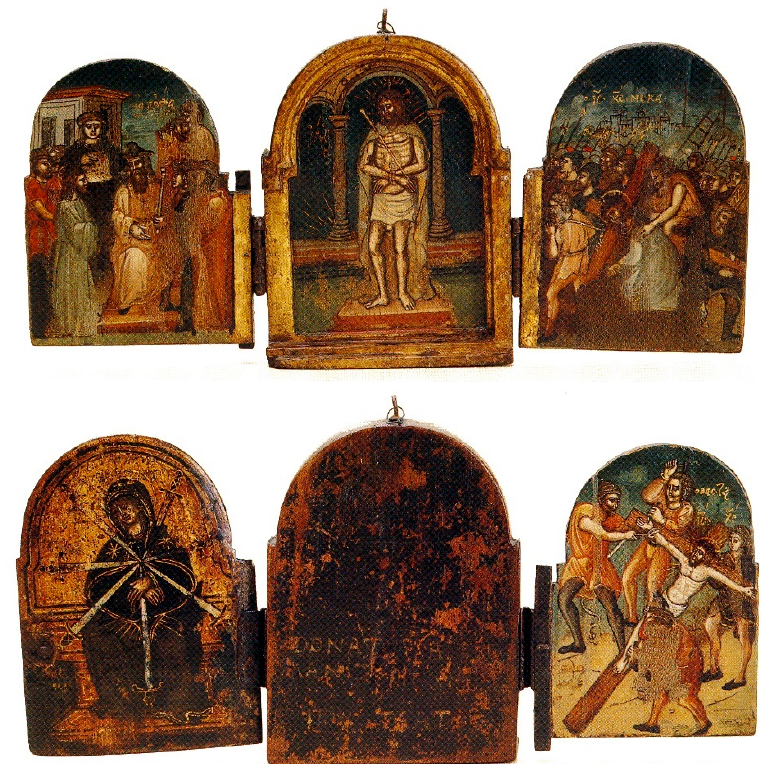
Figure 11. Donatos Bitzamanos, Triptych with Scenes of the Passion of Christ (recto and verso), painted in Otranto, San Marino, Museo di Stato (taken from Pasini 2000, Fig. 58).